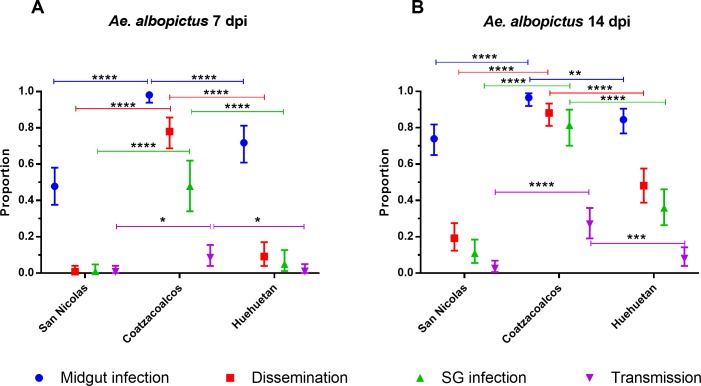
Midgut infection, dissemination, salivary gland infection and transmission rates of Ae. aegypti by collection.A) rates at 7 dpi and B) 14 dpi by collection location. San Nicolas is the furthest northern collection while Huehuetan is the furthest south. Error bars represent 95% confidence intervals. Data are from at least 2 independent replicates. Statistical significance is depicted as **** for p <0.0001, *** p<0.001, **p<0.01 and * p<0.05 by two-tailed Fisher’s exact test.